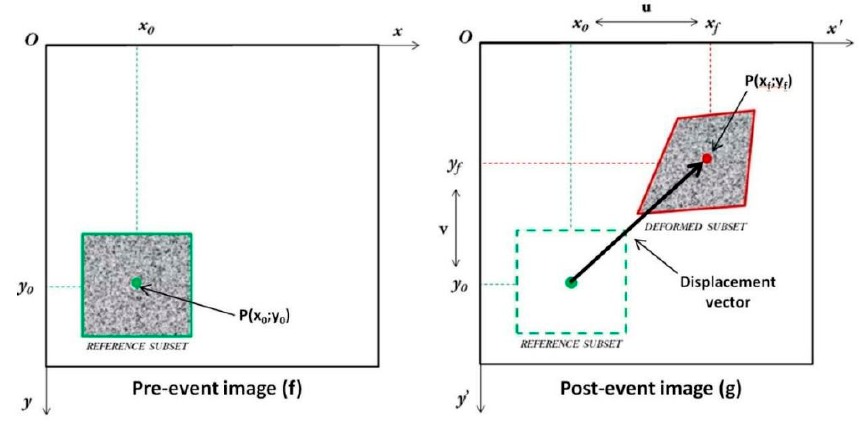
Figure 6. Scheme of DIC basic principle [70].